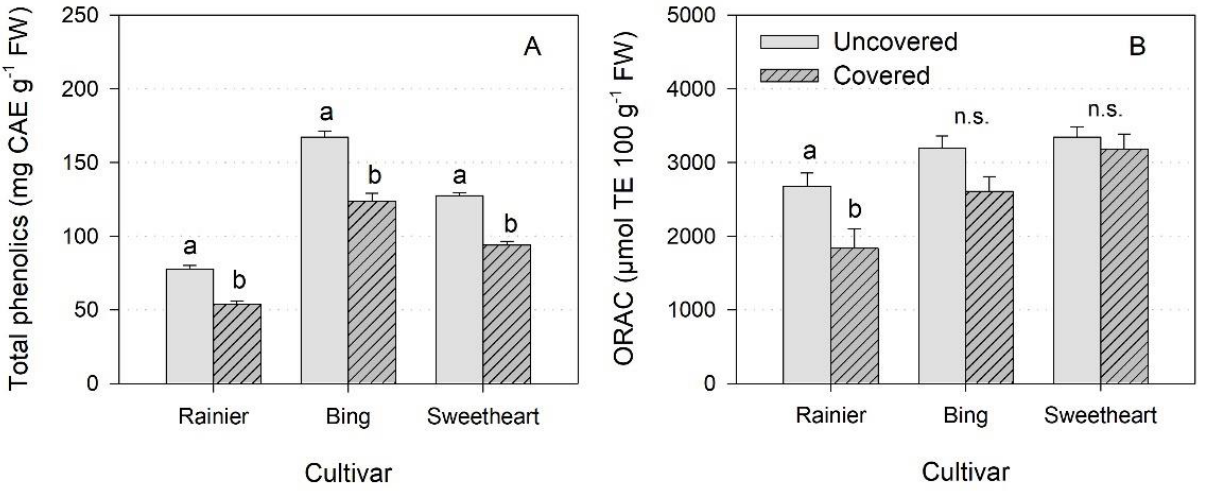
Figure 5. ( A ) Total phenol content and ( B ) ORAC antioxidant capacity of ‘Rainier’, ‘Bing’ and ‘Sweetheart’ sweet cherries with and without rain cover. Columns of a cultivar followed by the same letters indicate no statistical difference between treatments according to Tukey’s test ( p ≤ 0.05). Means + SE ( n = 5).